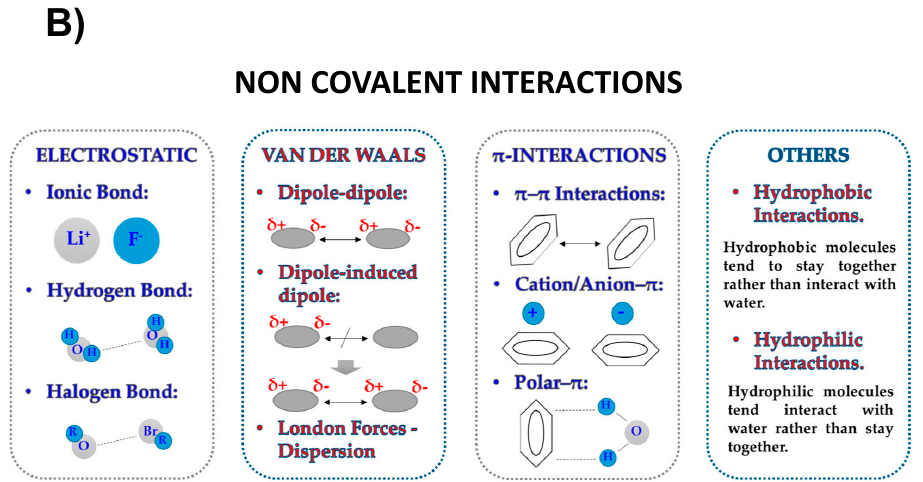
Figure 1. ( A ) Schematic comparison of the main differences between the “hard” corona and “soft” and ( B ) illustration of the different types of non-covalent interactions that could participate in the protein adsorption process adapted with the permission of [52].